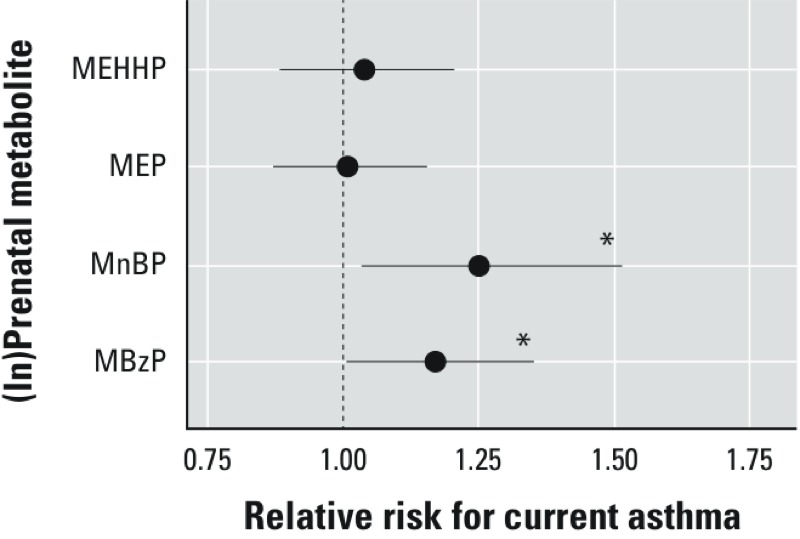
Association between maternal prenatal (ln)phthalate metabolite concentrations and diagnosis of current asthma (n = 94) compared with nonasthmatic (n = 146) between child ages 5 and 11 years. RRs were estimated using Poisson regression with robust standard error estimation using the generalized estimating equations controlling for maternal asthma, household tobacco smoke exposure, maternal prenatal BPA, maternal prenatal demoralization, child age, and maternal prenatal specific gravity.
*p < 0.05.